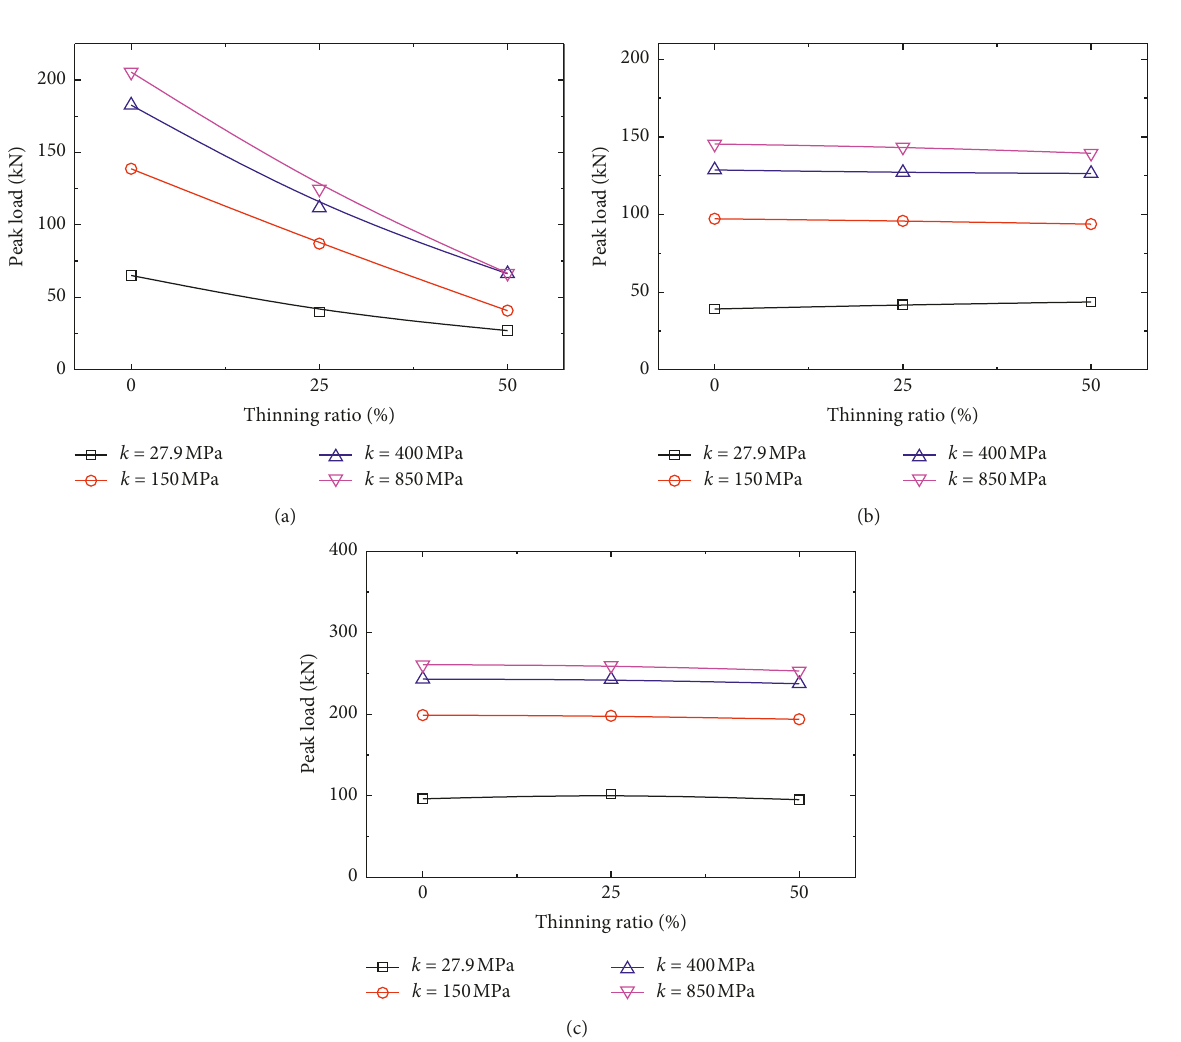
Figure 13: Variation curve of peak load-crown thinning ratio. (a) Vertical load. (b) 45 ° oblique load. (c) Horizontal